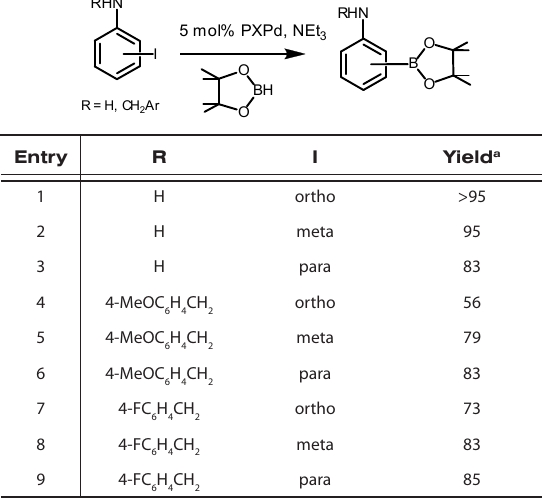
Scheme 2. Borylation of aniline derivatives containing trifluoromethyl